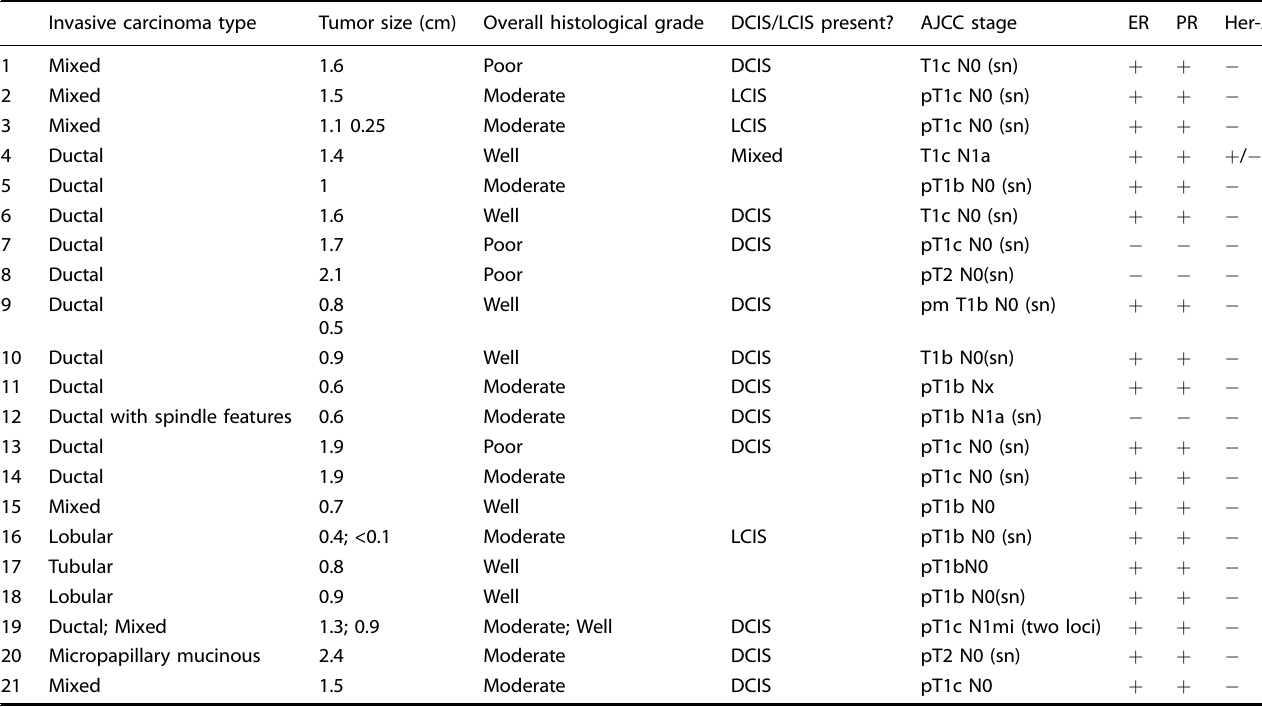
Table 1. Diagnostic characteristics from the initial 21 surgical cases with intraoperative MS analysis. Invasive carcinoma